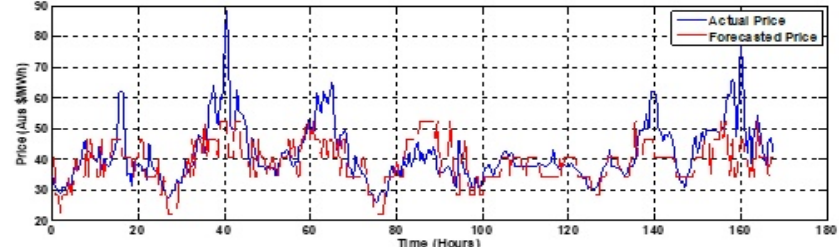
Figure 11. December 8–14, 2015 forecasting without feature selection in the summer season (MAPE = 13.08).